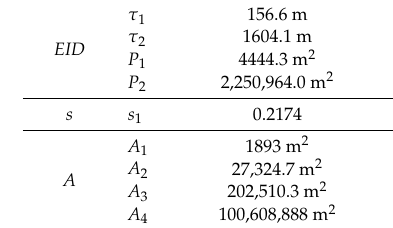
Table 3. Geomorphologic thresholds in the space of local slope and drainage area.